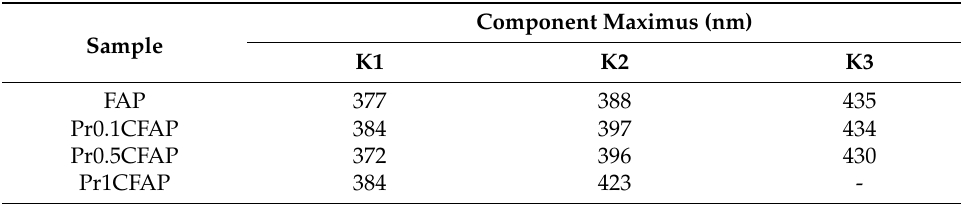
Table 4. Values of three-component analysis of the samples.